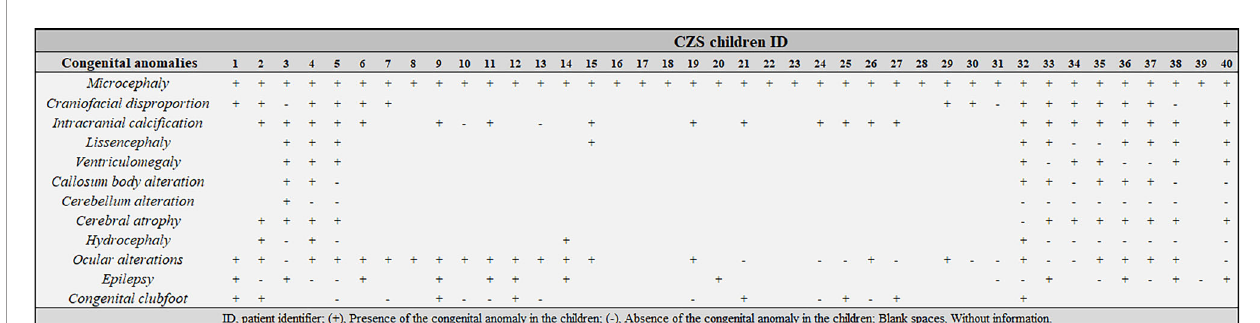
FIGURE 1 | Clinical characterization of children with Congenital Zika Syndrome (CZS) included in this study. ID, patient identi fi er; (+), Presence of the congenital anomaly in the children; (-), Absence of the congenital anomaly in the children; Blank spaces, Without